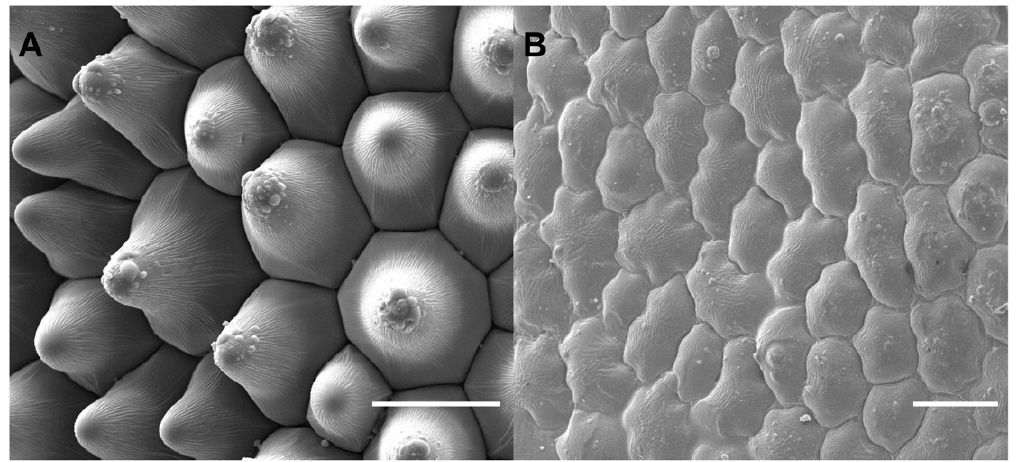
Figure 2. Conical-celled and flat-celled petal surfaces. A. Scanning Electron Microscope image (SEM) of wild-type Antirrhinum petal. B. SEM of mixta mutant Antirrhinum petal.